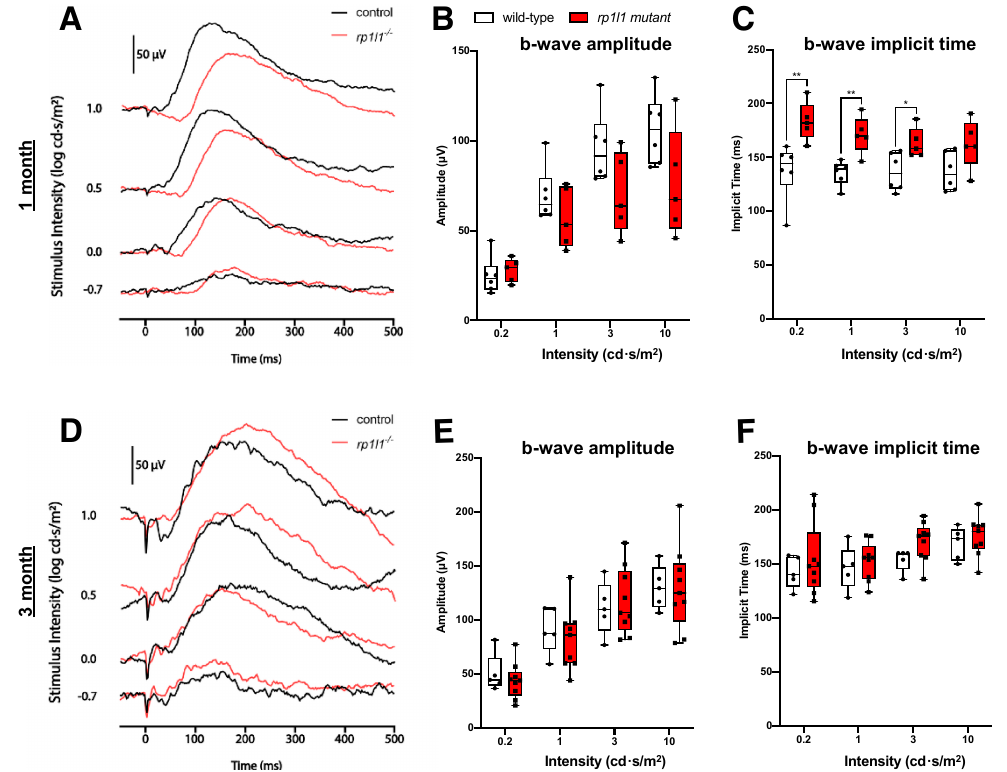
Figure 2. rp1l1 mutants have photoreceptor responses comparable to wild-type zebrafish at 1 and 3 months. ( A ) Sample traces from one mutant and one wild-type animal at 1 month of age. ( B ) b-wave amplitude is not di ff erent between wild-type and mutant fish. ( C ) 1-month-old mutant zebrafish have increased b-wave implicit time under 0.2, 1, and 3 intensities, indicating a delay in response. n = 6 for wild-type; n = 5 for mutant. ( D ) Sample traces from a 3-month-old wild-type and mutant animal. ( E ) b-wave amplitude and ( F ) implicit time are not significantly di ff erent between the groups. The box and whisker plots depict medians (center lines), upper and lower quartiles (boxes), and distributions (bars). Each dot is an individual animal. n = 5 for wild-type; n = 9 for mutants. * p < 0.05; ** p < 0.01.